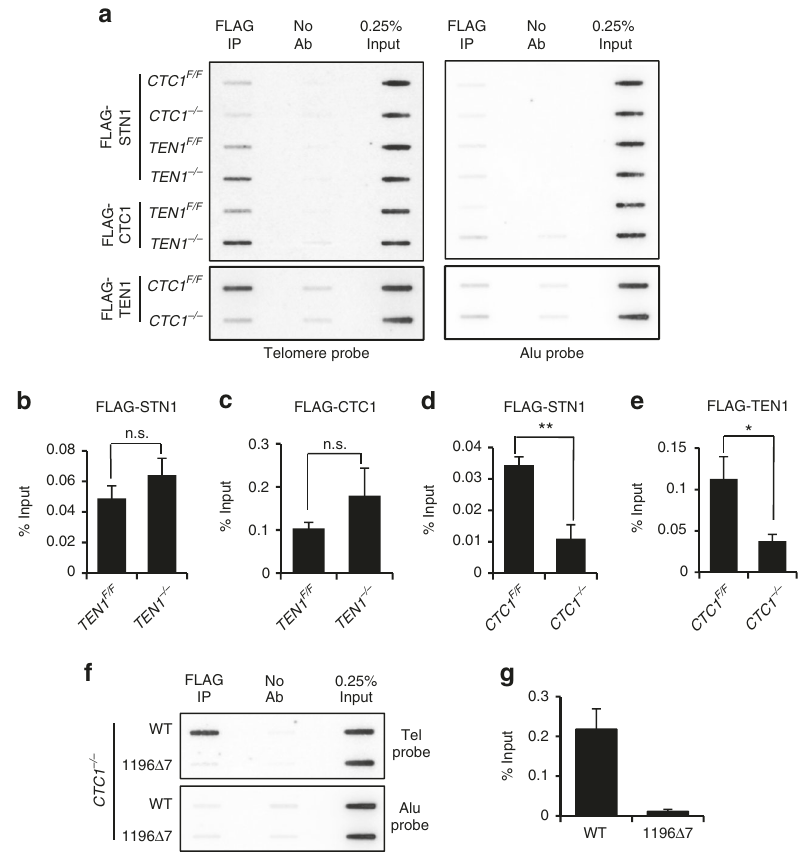
Fig. 4 CTC1-STN1 localizes to telomeres in the absence of TEN1. a – e ChIP showing exogenous FLAG-STN1, FLAG-CTC1, or FLAG-TEN1 localization at telomeres after TEN1 or CTC1 removal. a Representative slot blots to quantify FLAG-STN1, FLAG-CTC1, or FLAG-TEN1 localization to telomeres. Cells were grown with/without tamoxifen for 7 days. b – e Quanti fi cation of ChIP data for FLAG-STN1 ( b ) or FLAG-CTC1 ( c ) in TEN1 conditional cells, FLAG-STN1 ( d ) or FLAG-TEN1 ( e ) in CTC1 conditional cells. Alu probe served as a negative control. f – g ChIP analysis showing the CTC1 1196 Δ 7 mutant localizes to telomeres. CTC1 − / − cells expressed FLAG-CTC1 WT or FLAG-CTC1 Δ 7 and were grown with tamoxifen for 7 days. f Representative slot blots. g Quanti fi cation of ChIP data. N = ≥ 3 independent experiments, Error bars indicate mean ± SEM. * P < 0.05; ** P < 0.01; NS not signi fi